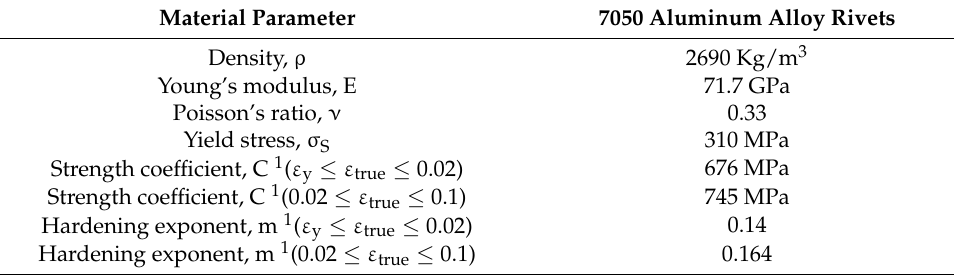
Table 2. Material parameters of 7050 aluminum alloy